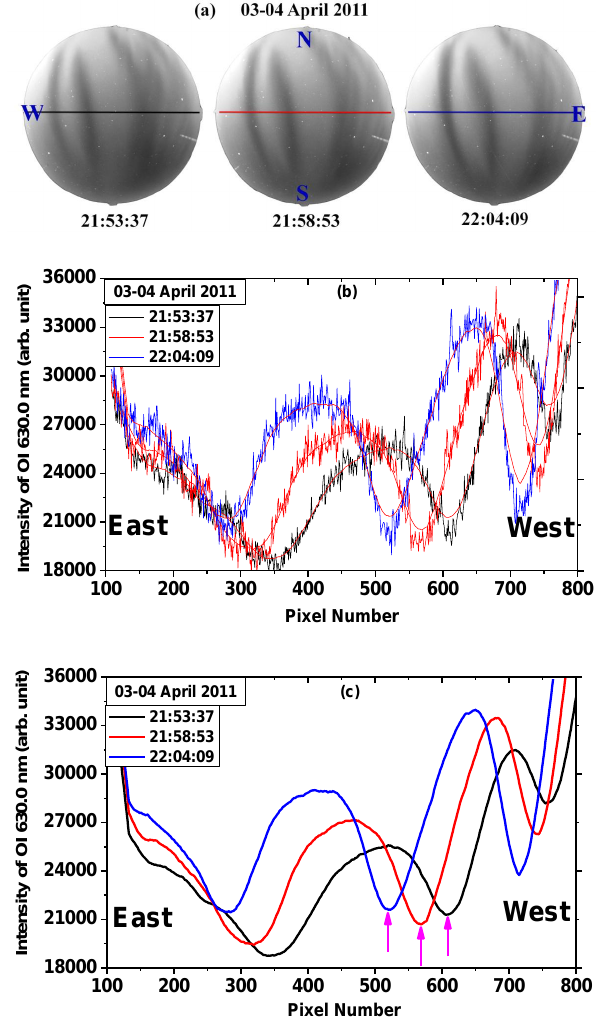
Fig. 3. The drift velocities of EPBs are determined from OI 630.0nm using a scanning method. (a) shows images of OI 630.0nm taken by ASI from Kolhapur at 21:53:37, 21:58:53 and 22:04:09IST on 3–4 April 2011. (b) shows east–west scan of de- pletion (EPBs) showing in (a) . (c) shows east–west scanned data smoothed by 50 points averaged and yellow arrows (in upward di- rections) indicates the center of EPB.